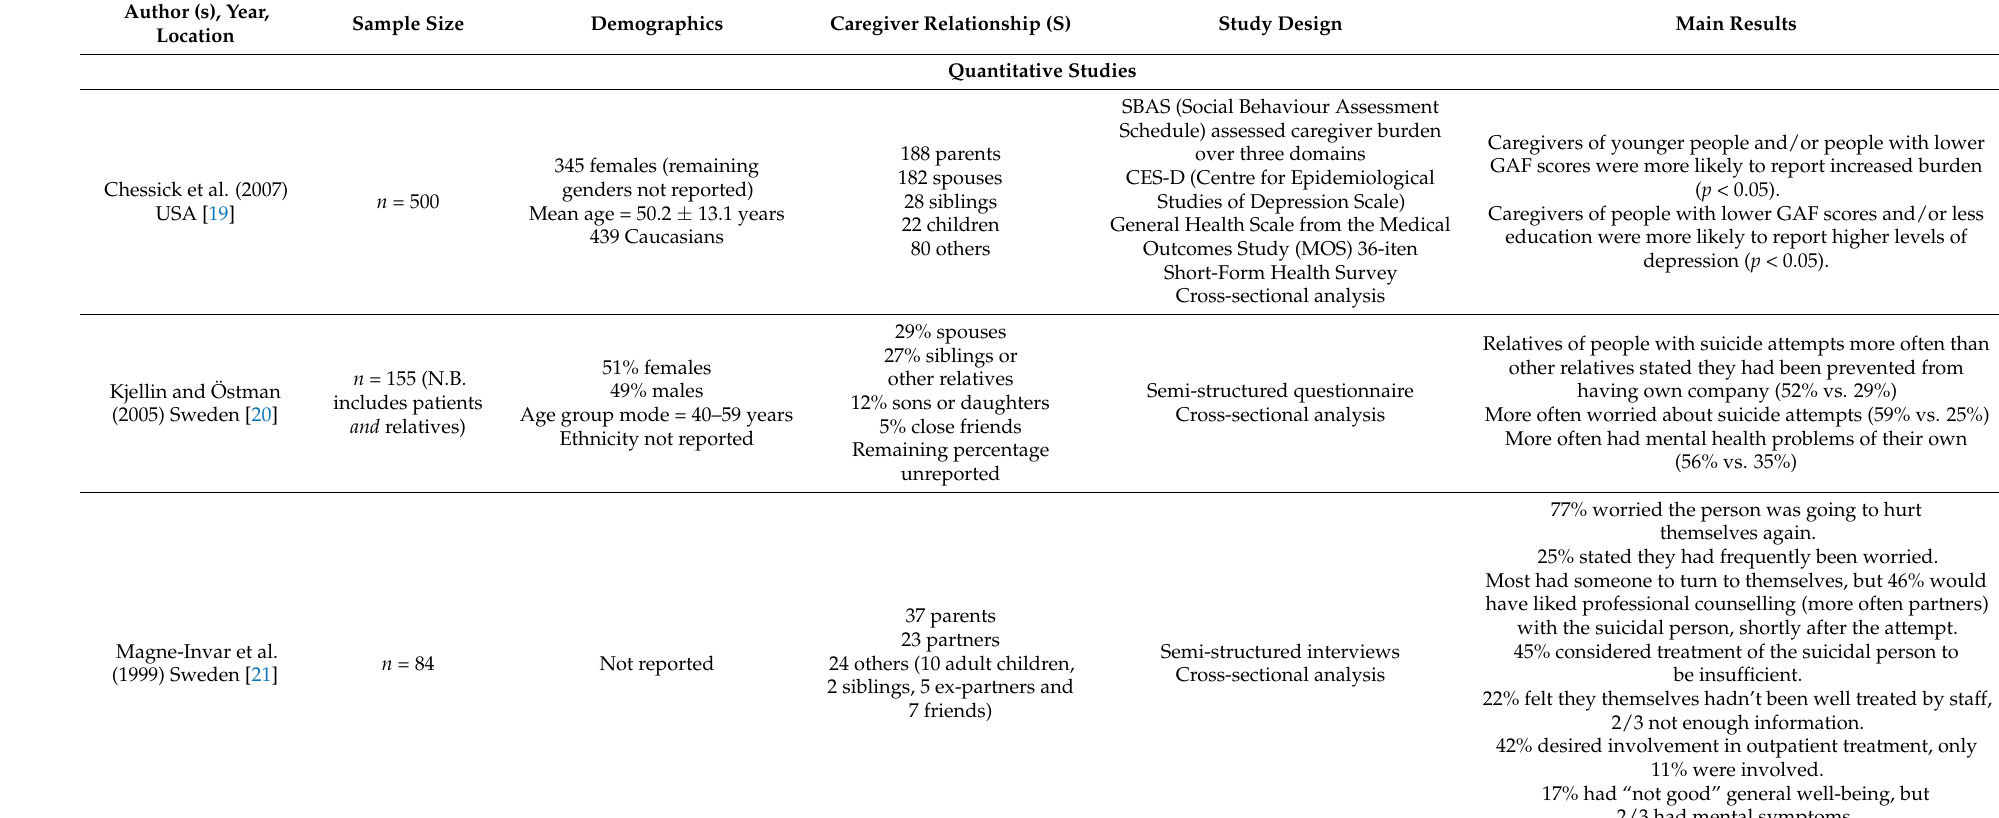
Table 1. Summary of included